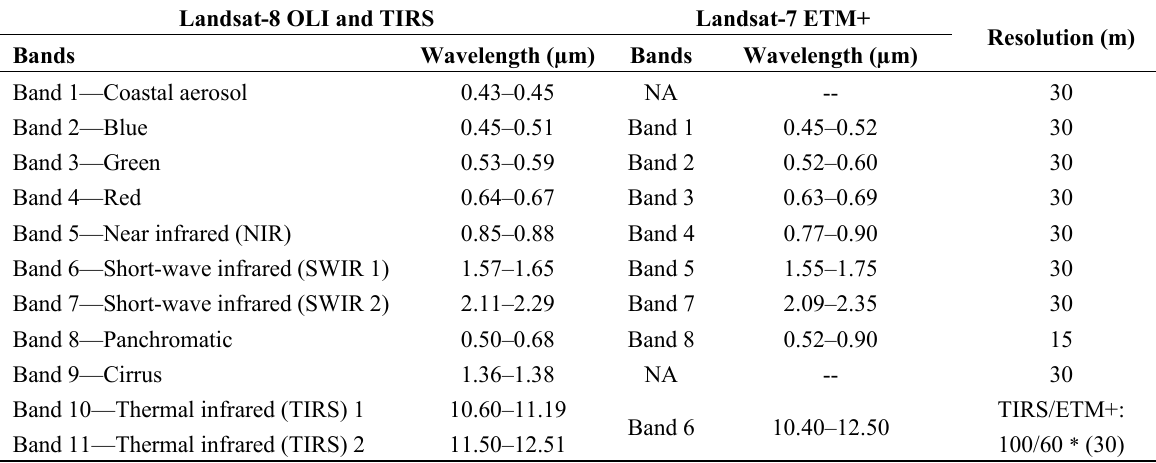
Table 1. Comparison of Landsat-7 ETM+ and Landsat-8 OLI/Thermal Infrared Sensor (TIRS) spectral